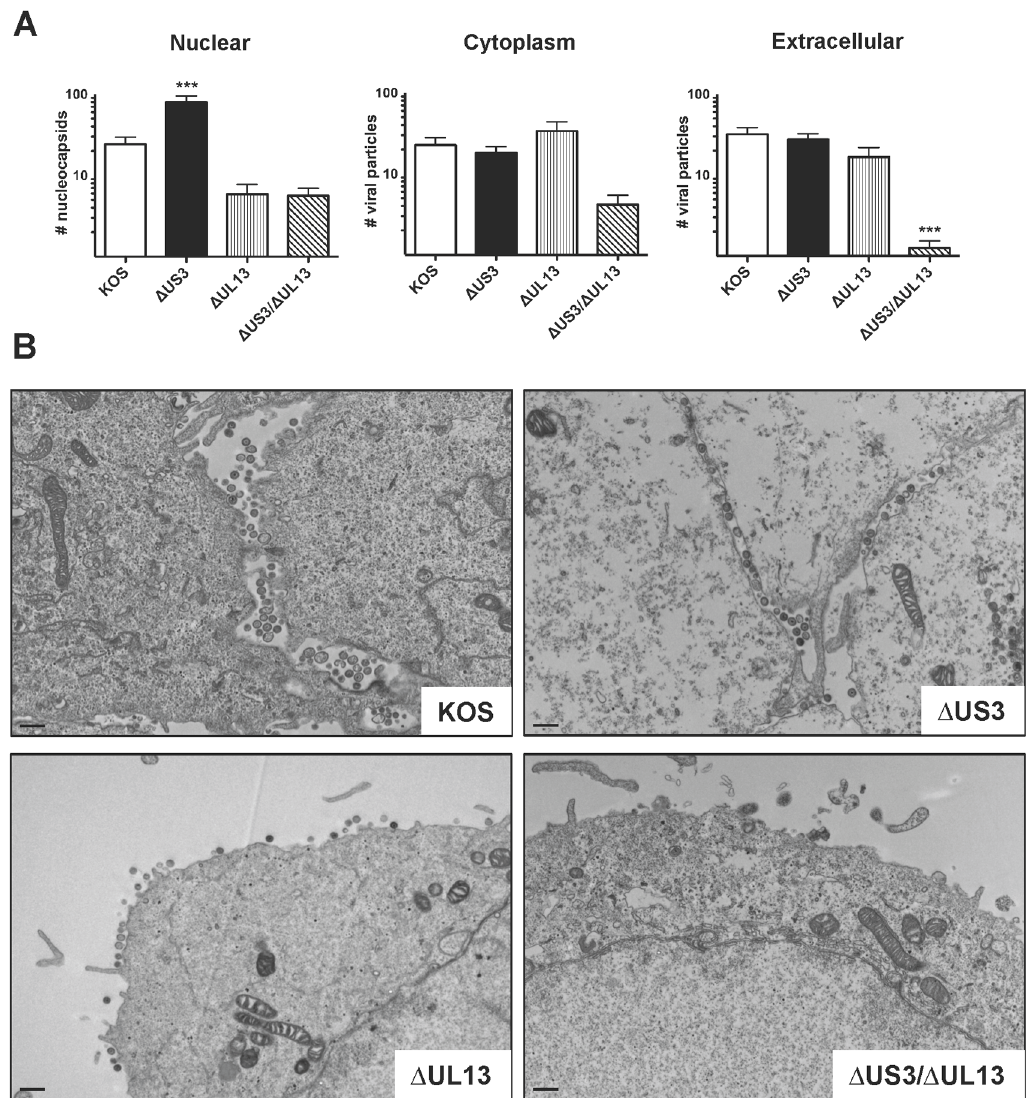
Fig 7. EM analysis of Vero cells infected with Δ US3 and Δ UL13 HSV-1 mutants. Monolayers of Vero cells on Thermonox coverslips were inoculated as described in Fig 3. At 16 hours post-inoculation, the monolayers were fixed and processed for EM analyses. (A) Separate images of nucleus, cytoplasm, and plasma membranes/extracellular space were recorded for 20 individual cells per each virus. The number of nucleocapsids and virions were manually counted in each image in a blinded fashion. Results are presented as the mean number of virions per compartment ± sem (n = 20; *** — p < 0.001). (B) Representative images of the plasma membranes/extracellular space for cells infected with different viruses (bars represent 500